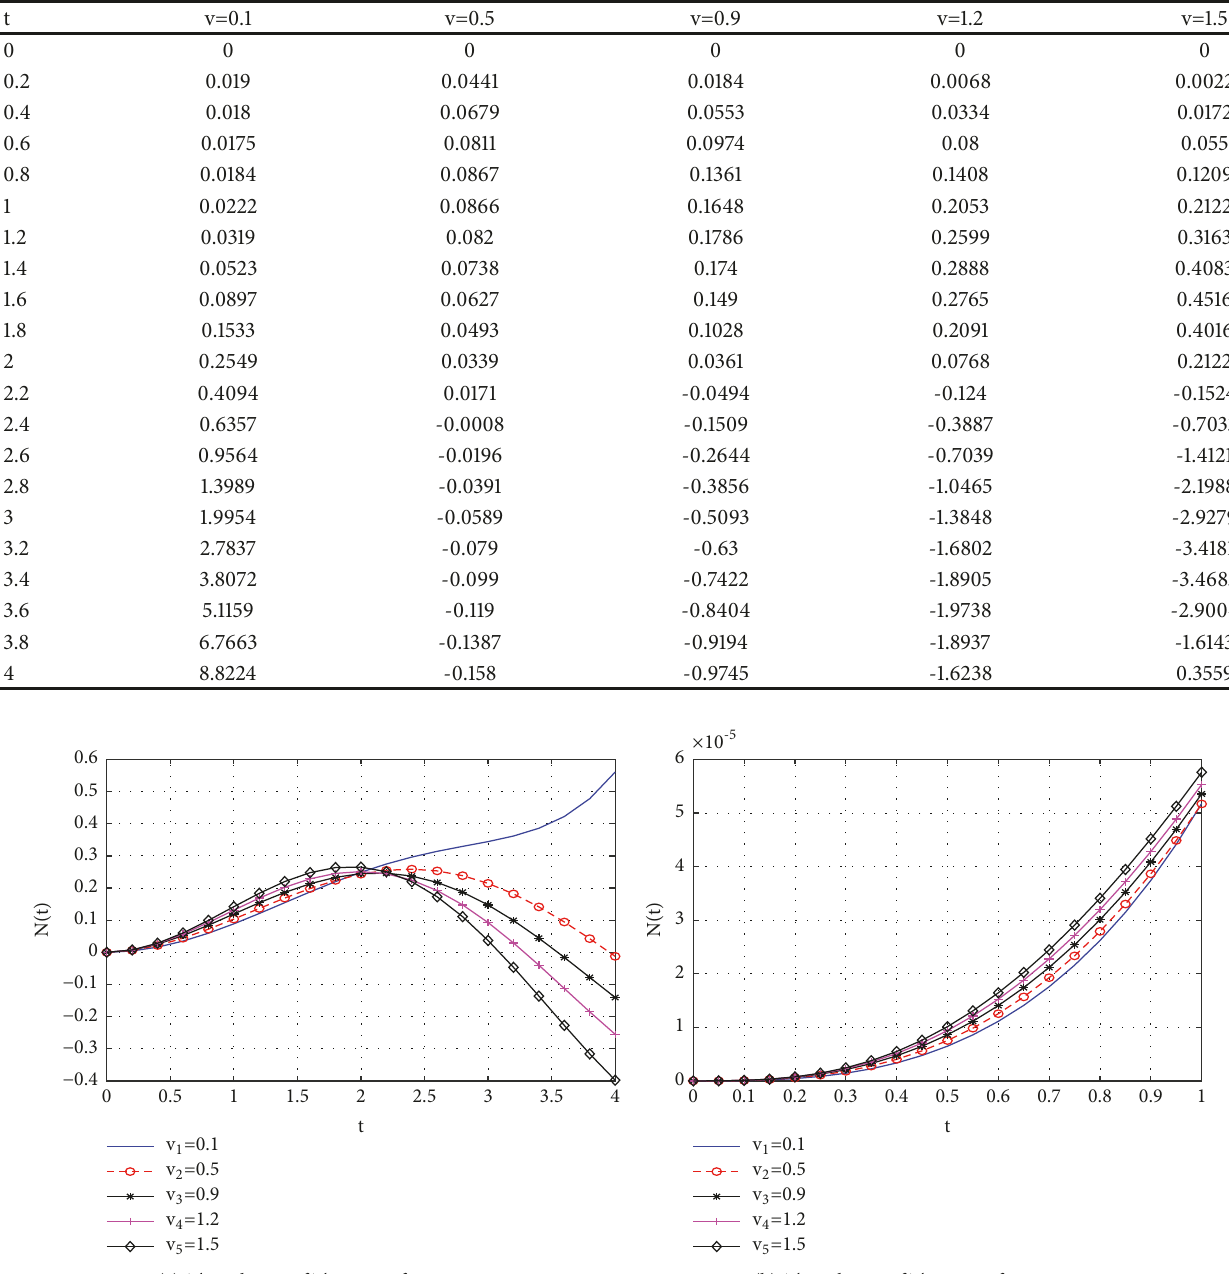
(b) The solution of Theorem 1 for t=0:0.05:1 Figure 1: Solution of fractional kinetic equation (18).